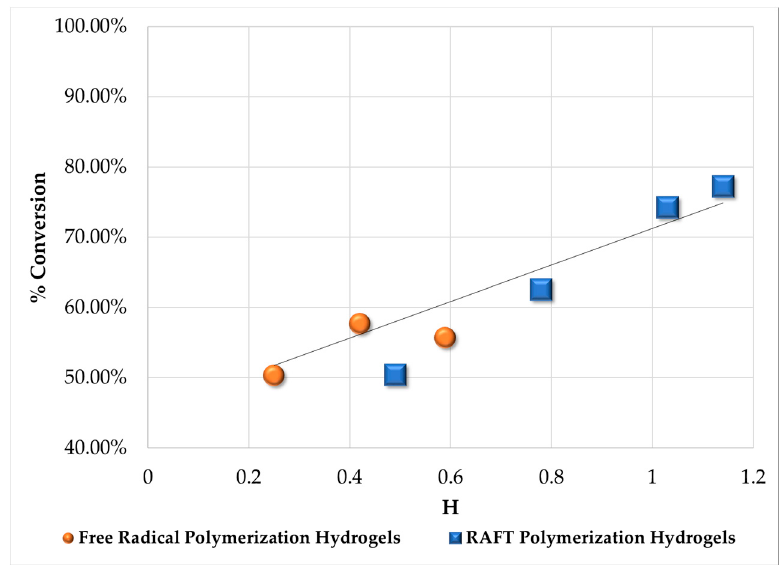
Figure 8. Relationship between conversion of pendant double bonds measured by FTIR and H .